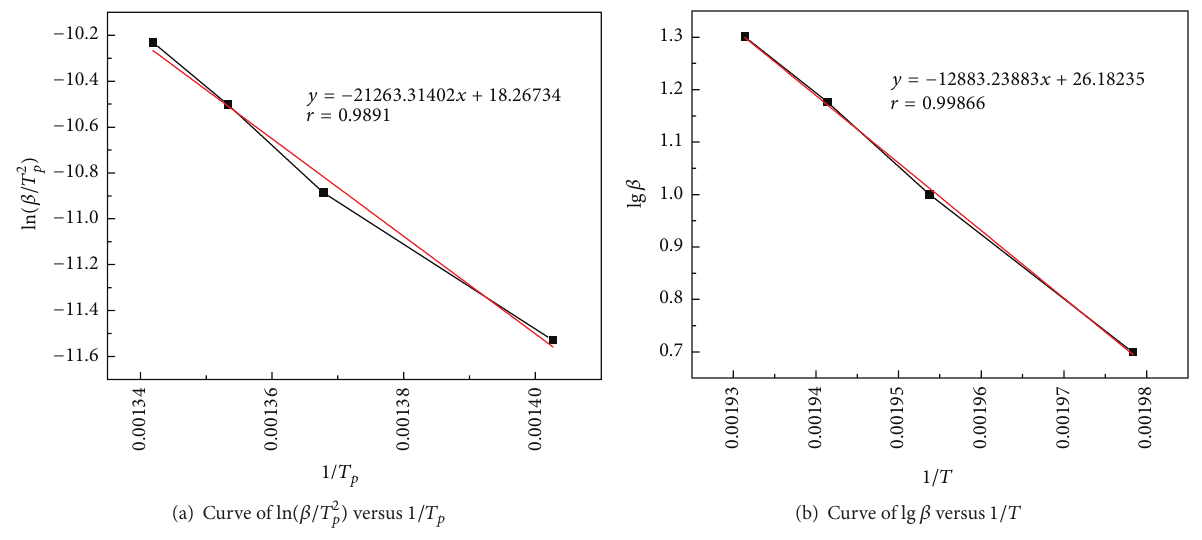
Figure 6: Linear relationship at different heating rates and 𝑇 𝑝 for the third